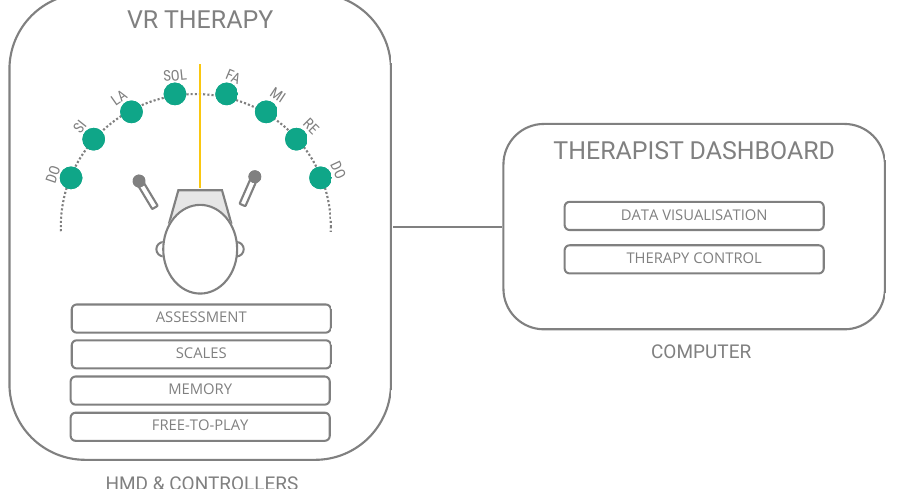
Figure 5. The designed VR therapy tool for USN consists of two modules: the VR therapy module, for the patient, who has to wear a HMD and use controllers, and the dashboard, accessible on a computer, where the therapist can control and oversee the